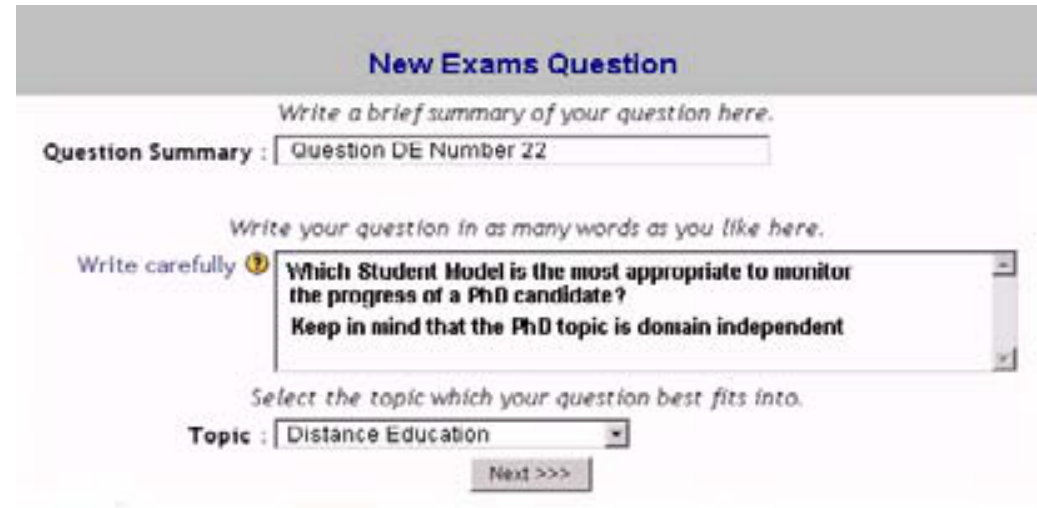
Figure 1. New exams question.